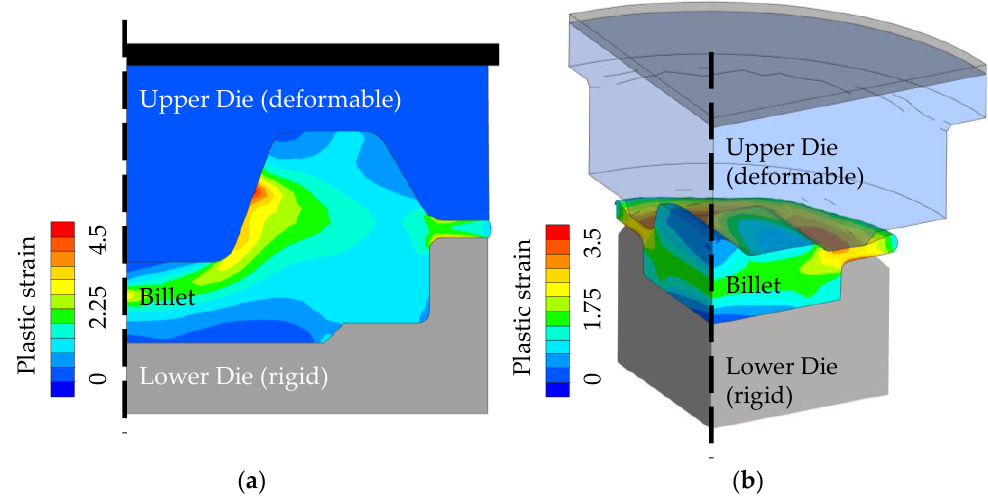
Figure 7. FE-Process model at the end of forming for dies ( a ) Type 1 and ( b ) Type 2.